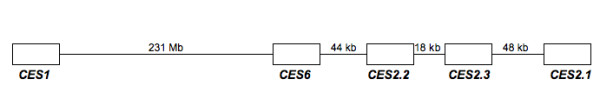
Schematic representation of the CES genes on chromosome one of the opossum.